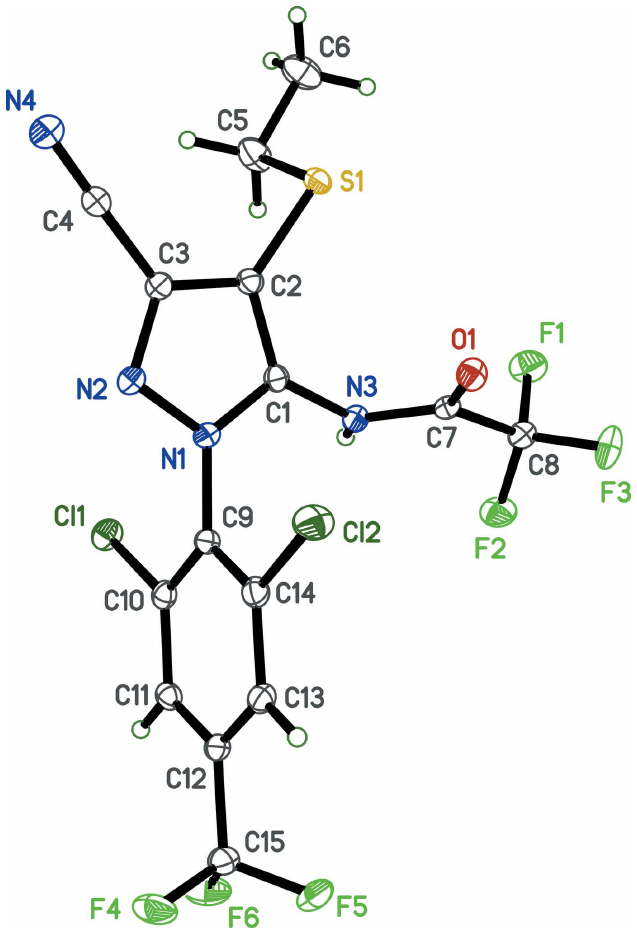
Figure 1 An ellipsoid plot (50% probability) of I .